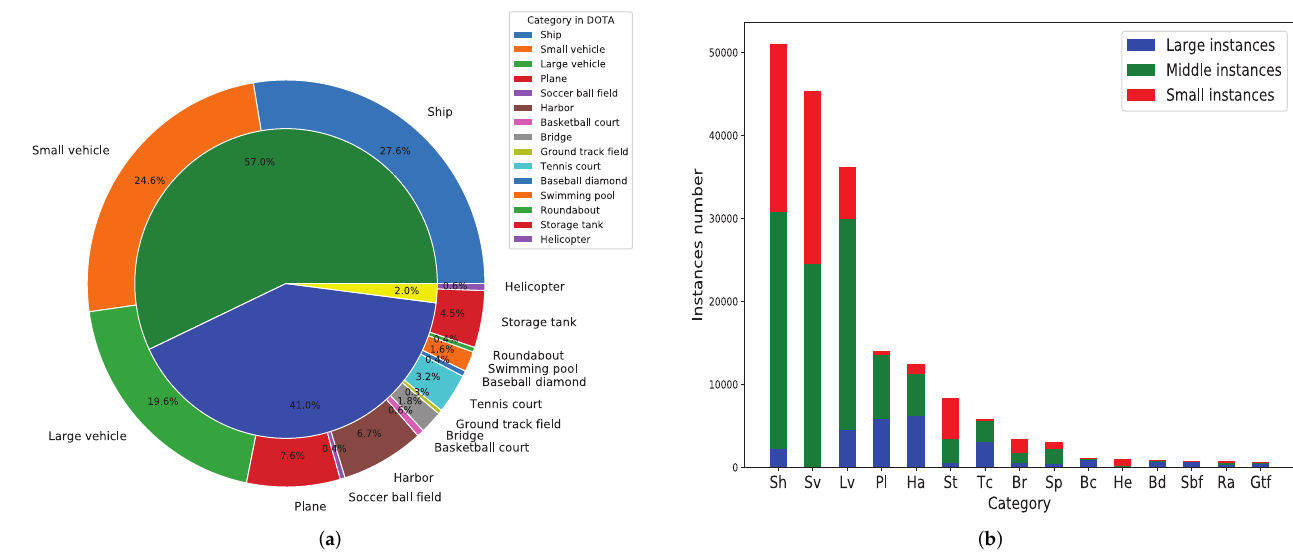
Figure 6. ( a ) The proportion distribution of the numbers of instances in each category in the DOTA dataset. The outer ring represents the number distribution of 15 categories. The internal ring denotes the total distribution of small (green), middle (blue), and large instances (yellow). ( b ) The size distribution of instances in each category in the DOTA dataset. We divided all of the instances into three splits according to their OBB height: small instances for heights from 10 to 50 pixels, middle instances for heights from 50 to 300 pixels, and large instances for heights above 300